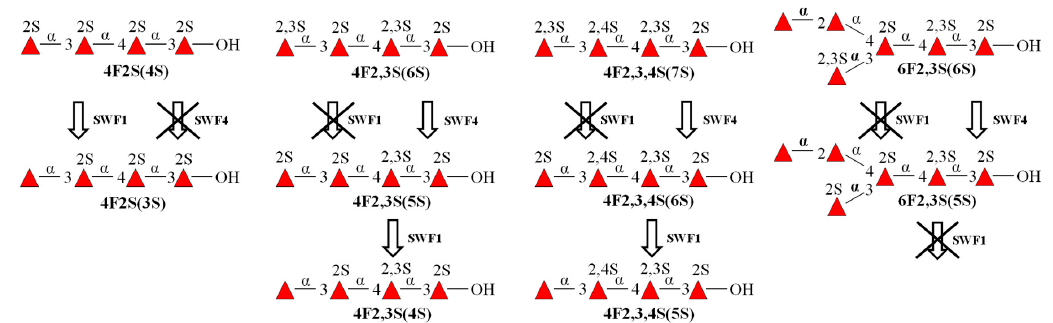
Figure 7. The scheme of sulfatases SWF1 and SWF4’s effects on various sulfated fucooligosaccharides produced by fucoidanases FFA1 and FFA2 from the marine bacterium Formosa algae .